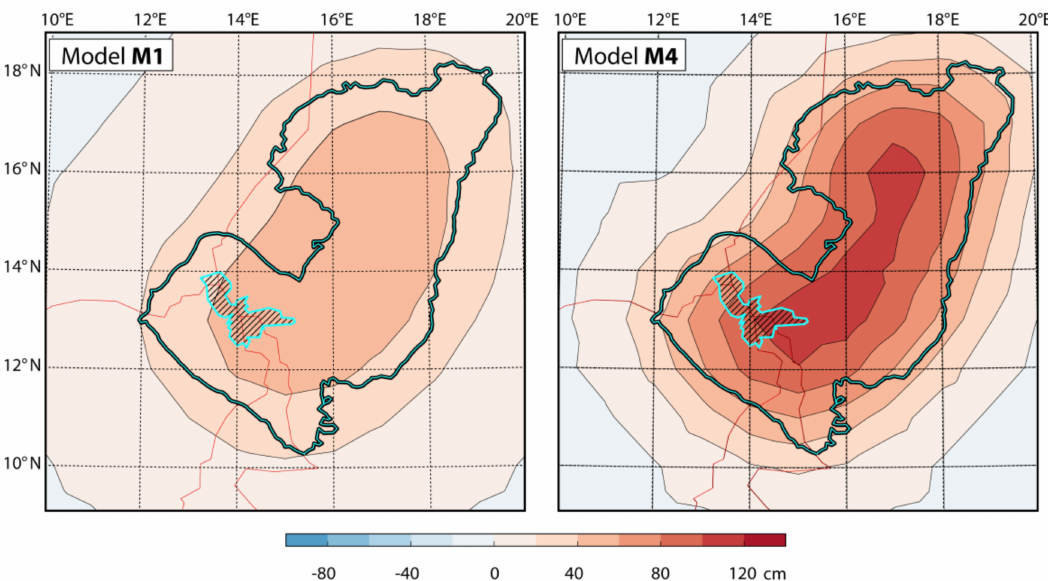
Figure 4. Vertical displacement (in cm) computed for an additional water load related to a 4 m thick overflow at the Mayo Kebbi spillway. Being mostly in the 0.5–1 m range, the subsequent correction that could be applied is arguably subordinate relative to the modeled total hydro-isostatic rebound (Figure 2) and thus has been neglected in reconstructions proposed in Table